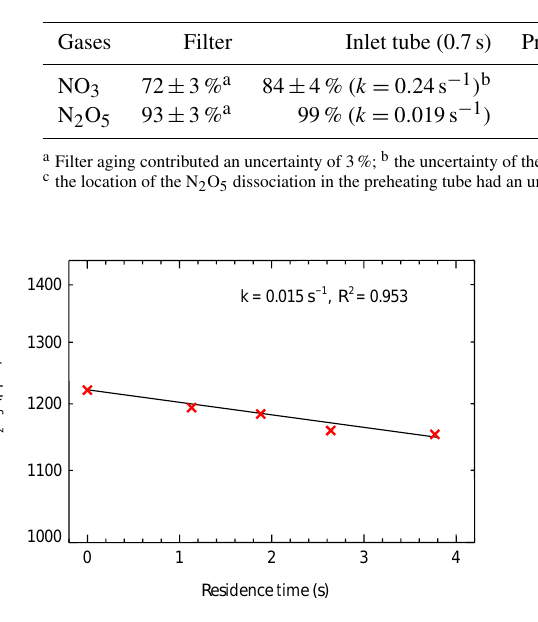
Figure 8. The determined concentrations of N 2 O 5 versus the res- idence time of the sample gas flows in the inlet tube. The change of the residence time is achieved by changing the inlet tubes hav- ing different lengths. The red crosses denote the observation results, and the black line depicts the corresponding exponential fit. The net wall loss reactivity of N 2 O 5 is corrected to be 0.019 ± 0.002s − 1 with a box model simulation of the chemical reactions occurring in the inlet